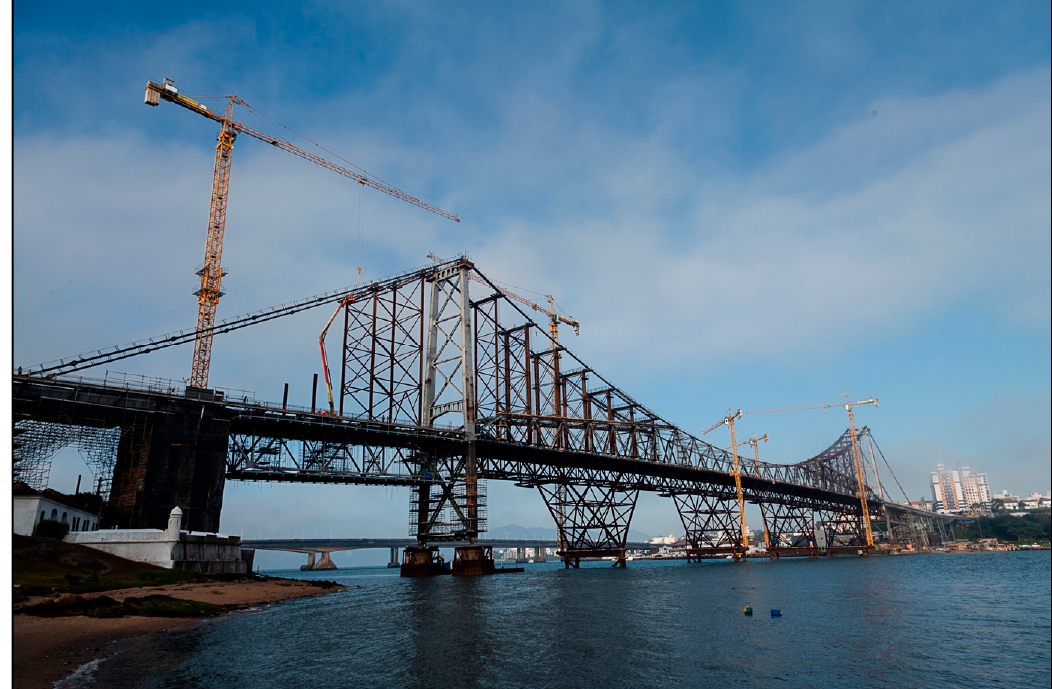
Figure 9. A view of the Hercílio Luz Bridge, reproduced with permission from Eduardo Trauer (photo taken in February 2018).